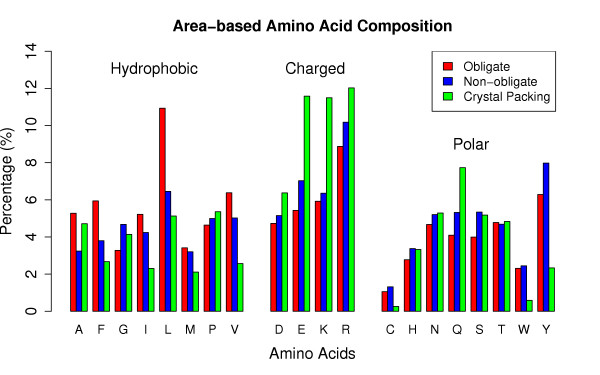
Area-based Amino Acid Composition for three types of interactions in the BNCP-CS dataset.